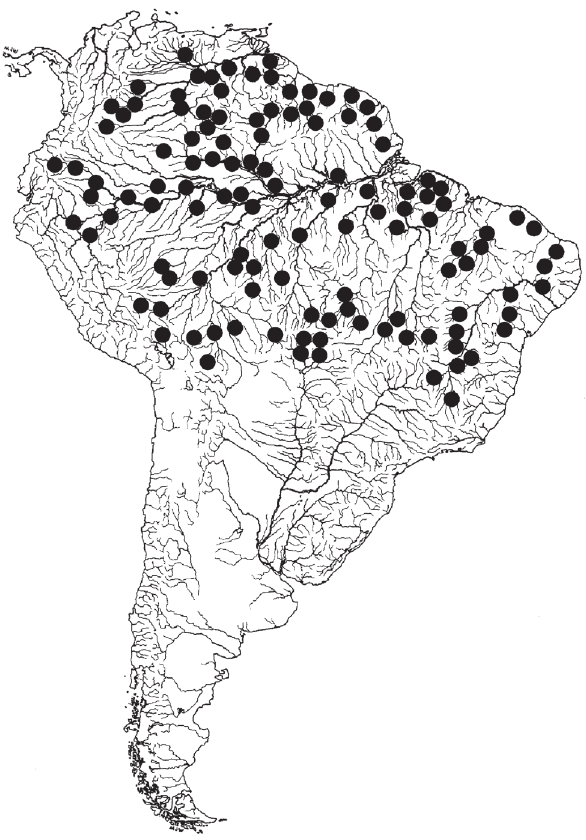
Figura 1. Distribuição das espécies de Phenacogaster com base em material